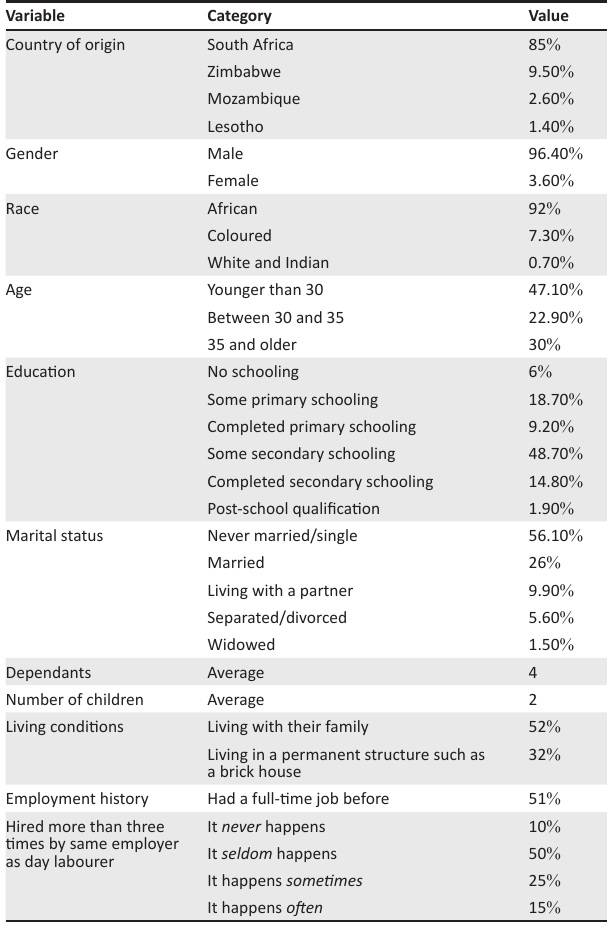
TABLE 2: Demographic profile and employment history of day labourers in South Africa, 2007‒2008.